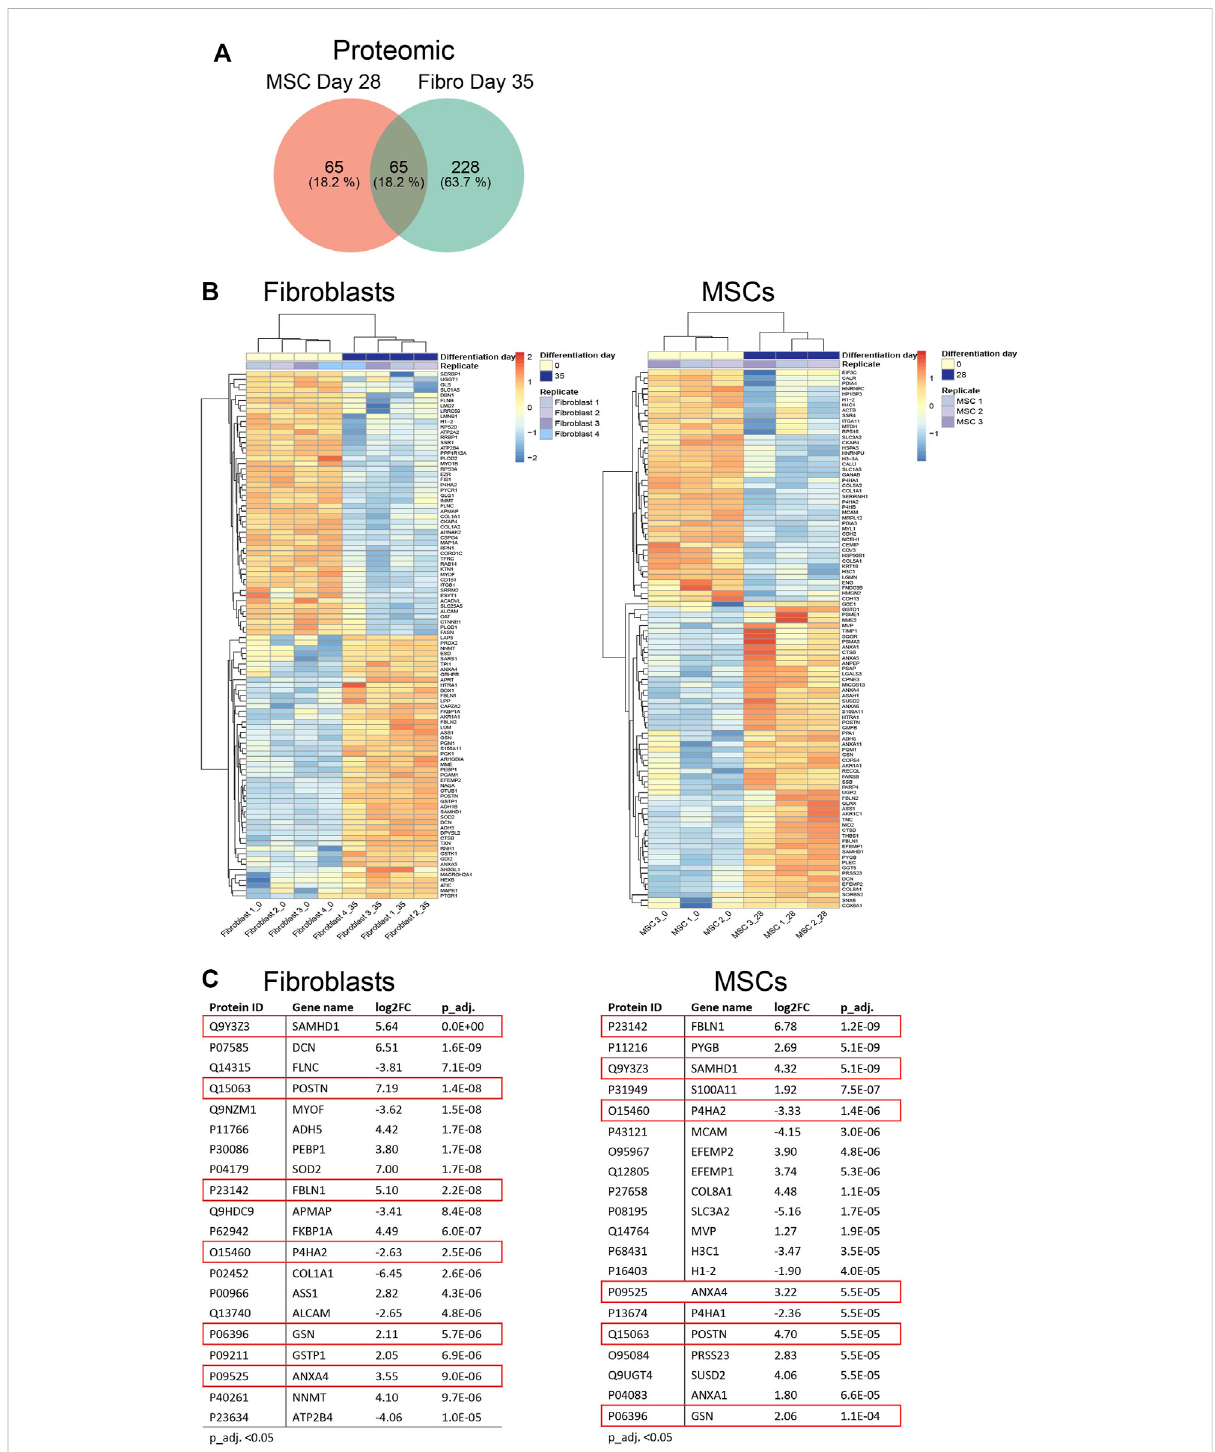
FIGURE 5 Differential protein expression in fi broblasts and MSCs at endpoint. (A) Venn diagram comparing total number of differentially expressed proteins in fi broblasts and MSCs, undifferentiated state (Day 0) versus differentiated state (Day 35 in fi broblasts/Day 28 in MSCs). In both cell types, 65 proteins were included, 65 proteins were exclusively expressed in MSCs while 228 proteins were exclusively expressed in fi broblasts. (B) Top 100 and (C) Top 20 differentially expressed proteins in MSCs and fi broblasts comparing undifferentiated state to last time point.